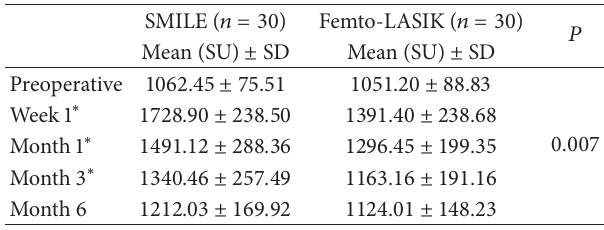
Table 5: Backscattered light intensity 120 𝜇 m below the epithelium.